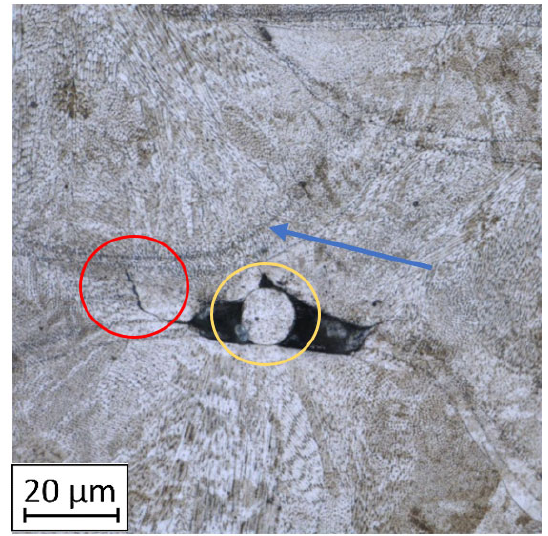
Figure 8. Microstructure of the AM M300 in BHT condition with marked crack (red circle) from non ‐ melted grain (yellow circle) and visible melt ‐ pool boundary (blue arrow).